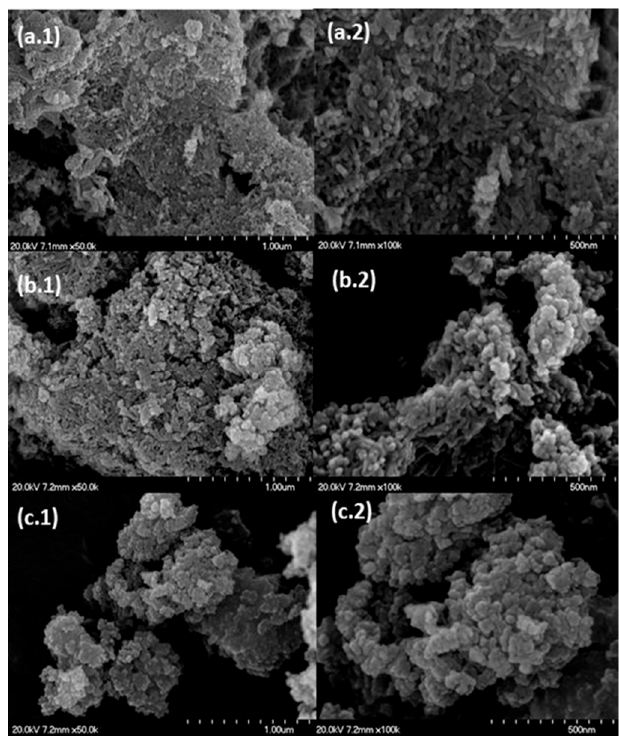
Figure 2. Scanning electron microscope (SEM) micrographs of the hydroxycarbonate precursors ( a ) W/O, ( b ) W1, ( c ) W3 with two magnifications: (1), ×50,000, and (2), ×100,000. ( a ) W / O, ( b ) W1, ( c ) W3 with two magnifications: (1), × 50,000, and (2), ×